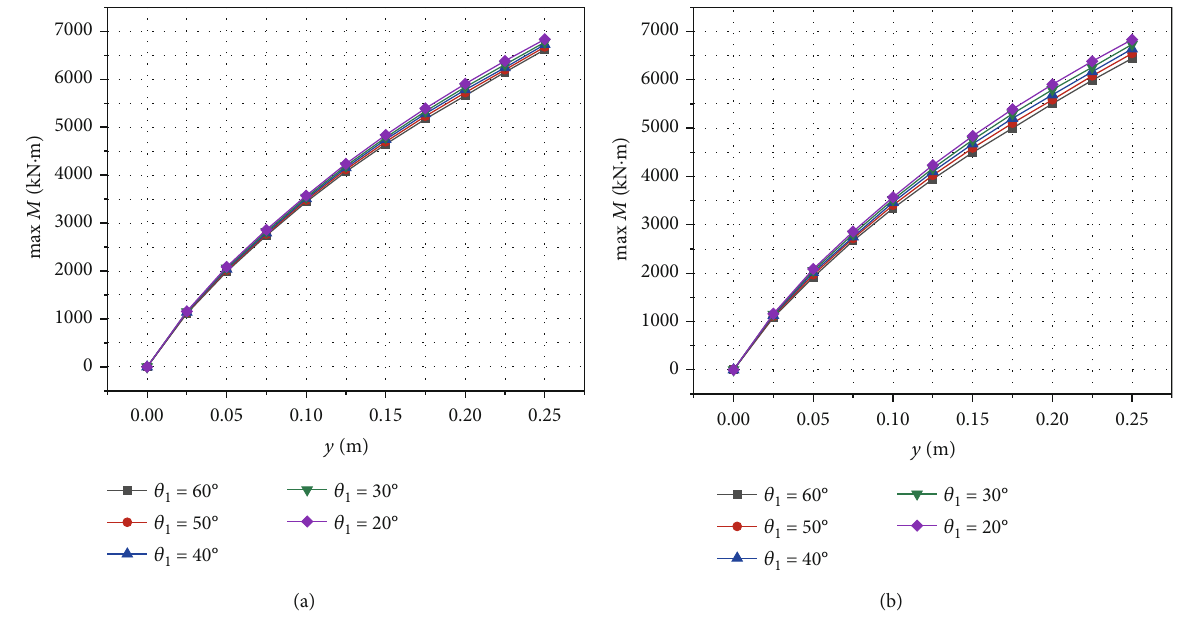
Figure 16: E ff ect of θ